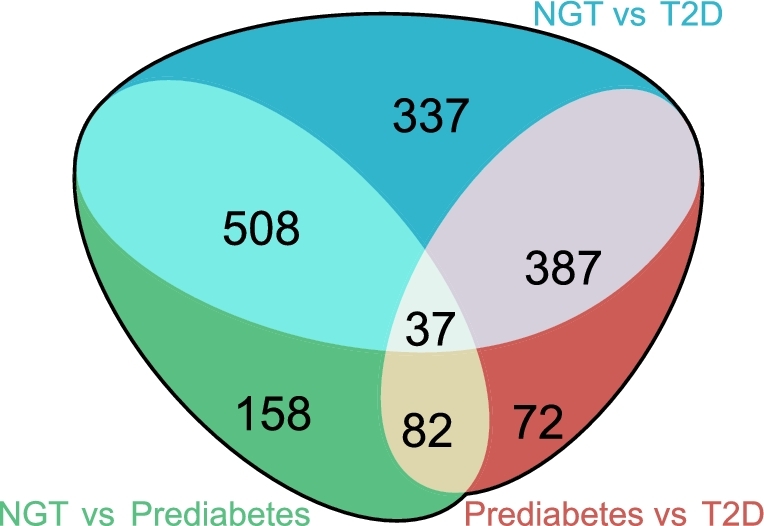
Venn diagram of significant metabolites from the 3 pairwise comparisons. Venn diagram depicting the number of significant metabolic features from 3 pairwise comparisons (the direction of change was ignored, P < 0.05, Dunn's post hoc test).